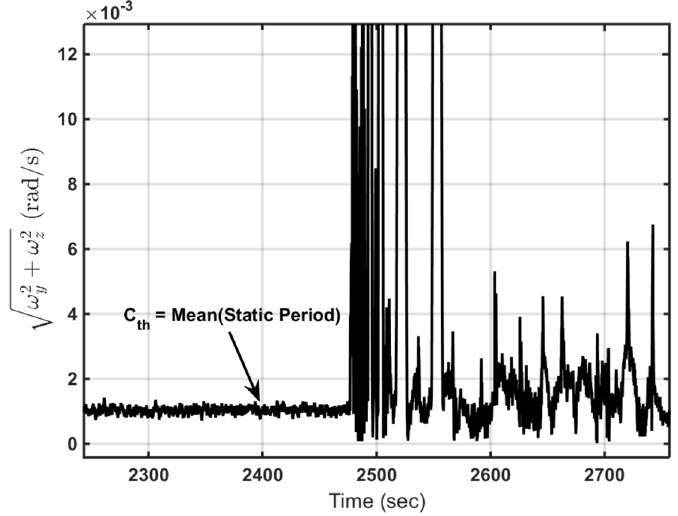
Figure 10. Selecting threshold criteria.